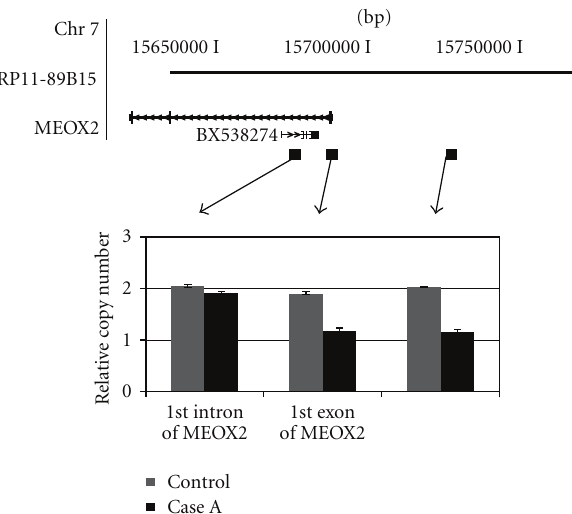
Figure 3: Characterization of a loss-type CNV detected on a BAC- clone RP11-89B15. A genome map of the RP11-89B15-containing region was obtained from the UCSC Genome Browser website. The distance (bp) from the p-terminal of chromosome 7 is shown in the uppermost part. That region contains the gene which is the gene mesenchyme homeobox 2 ( MEOX2 ). The positions of PCR primers examined are shown by solid boxes. The experimental conditions are described more precisely in the text. The relative copy number of each site was normalized using the quantity of the amplified segment of a portion of a di ff erent chromosome (Chromosome 16) as a standard (relative copy number = 2) and was shown as mean ± SD ( n = 3). The individual (Case A) has variant fragments with a deletion that contains the 1st exon and 5 (cid:4) -end of the MEOX2